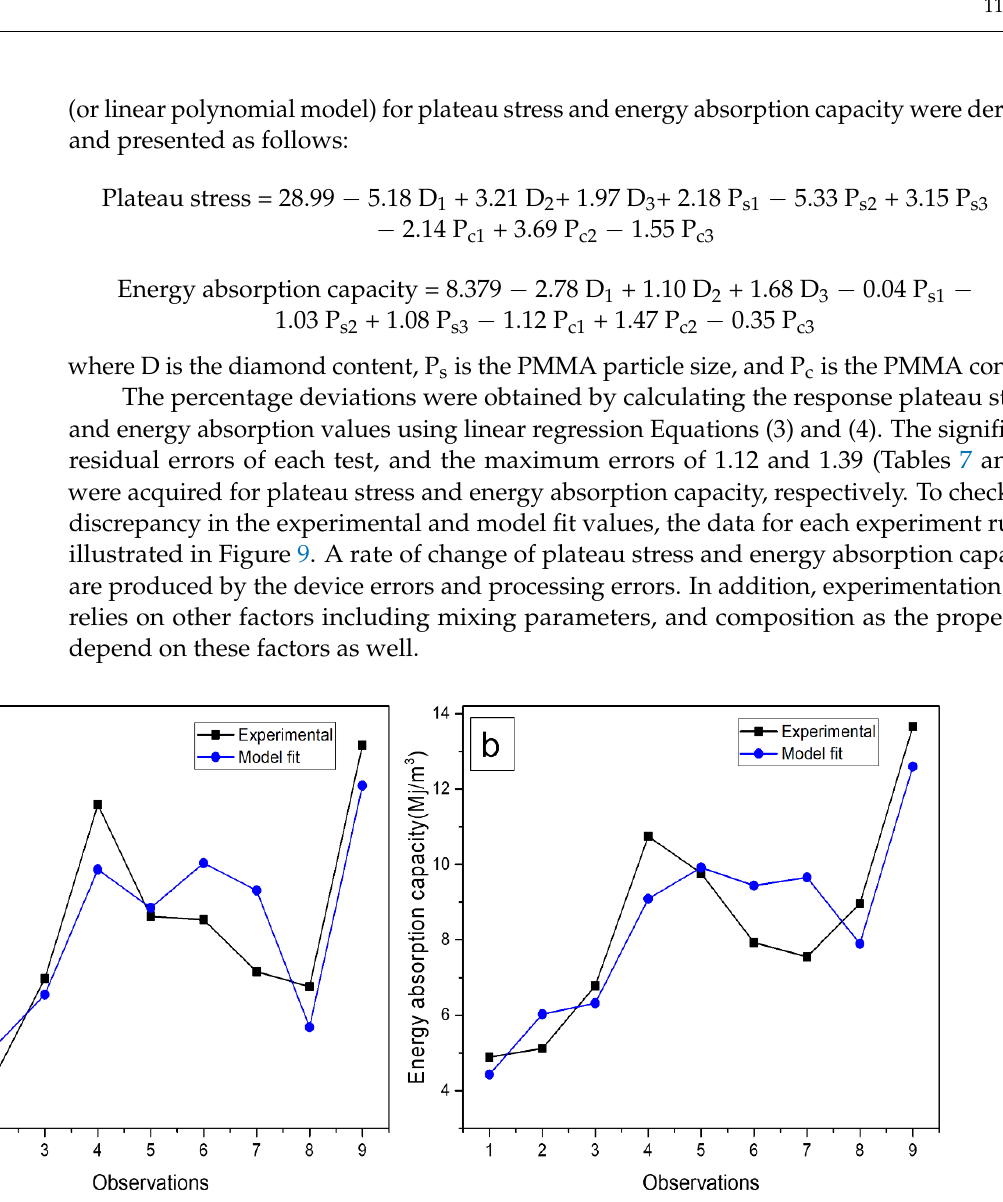
Table 8. Fits and diagnostics for all observations for energy absorption capacity.